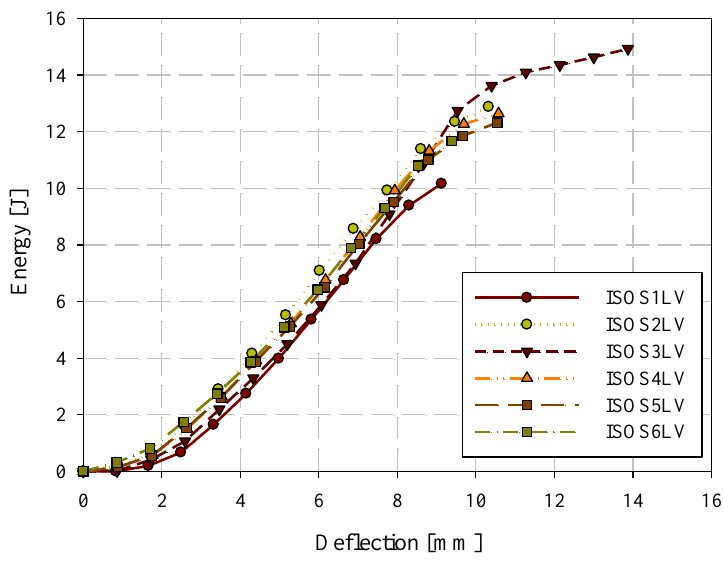
Figure 16. Low-velocity impact puncture energy-deflection responses.